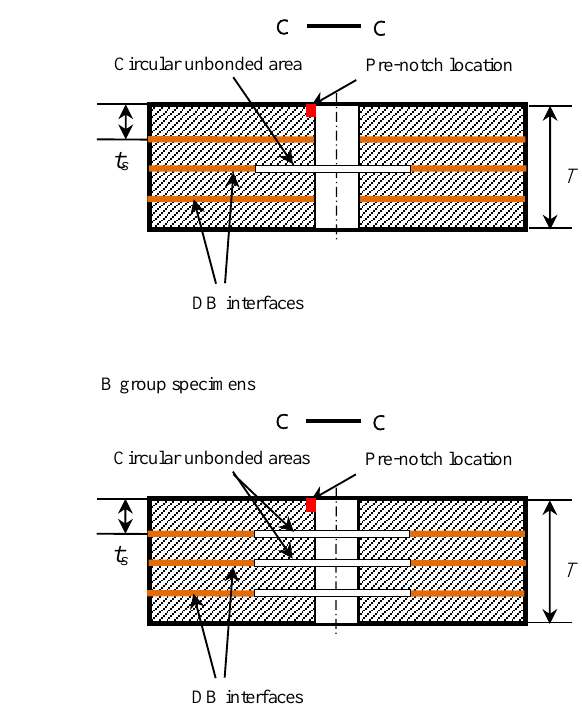
Figure 1. The pre-notch shape and location. The specimens had a length of L = 180 mm, a width of W = 40 mm, and a thickness of T = 8 mm. The layout of the specimens is shown in Figure 2.